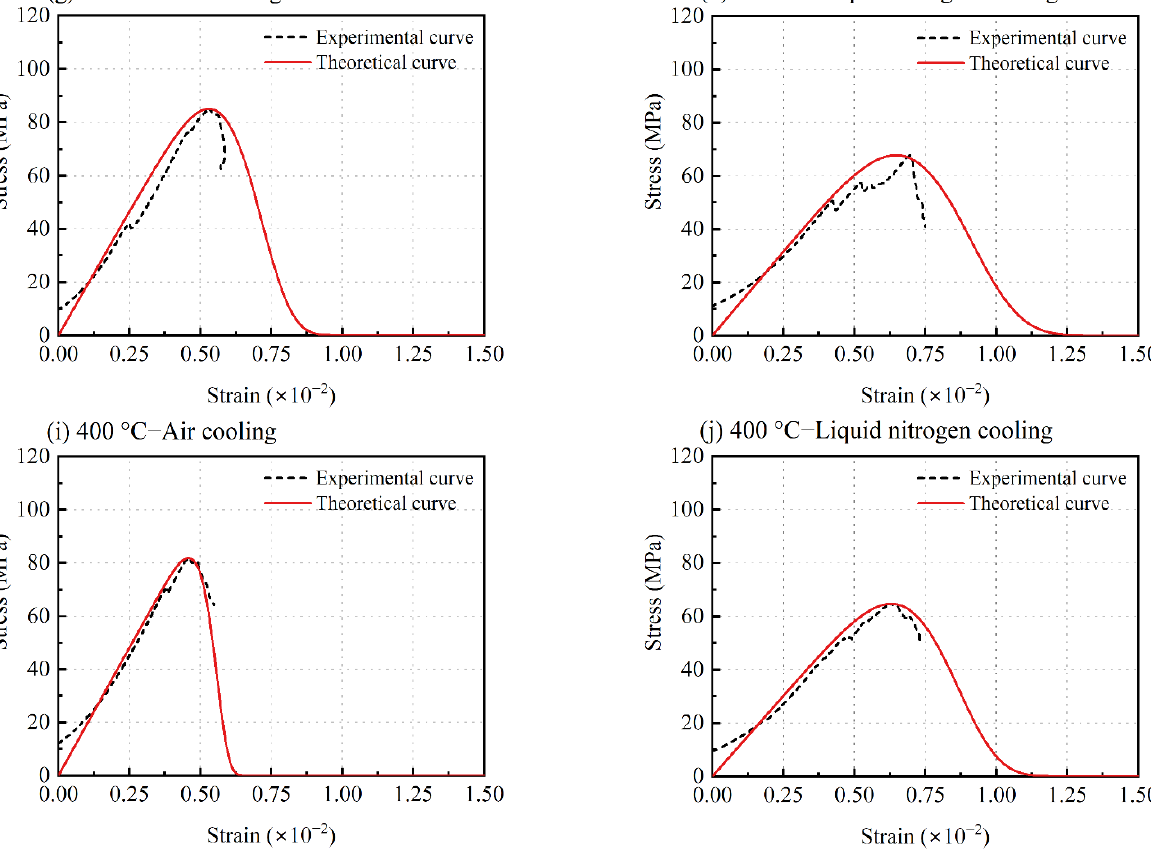
Figure 6. Experimental and theoretical stress–strain curves for heated granite after different cooling treatments.